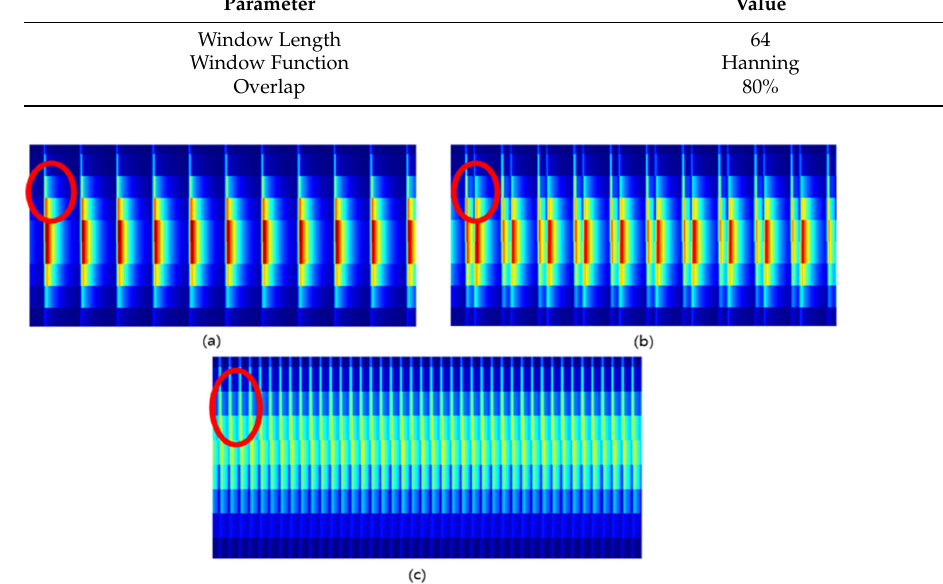
Figure 19. Final results of applying both order analysis and STFT [( a ): flat 1ea, ( b ): flat 2ea, ( c ): flat 4ea].